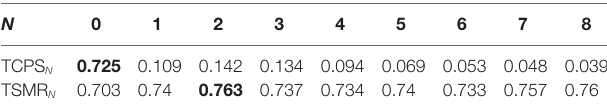
TaBle 3 | Optimization and temporal information results.